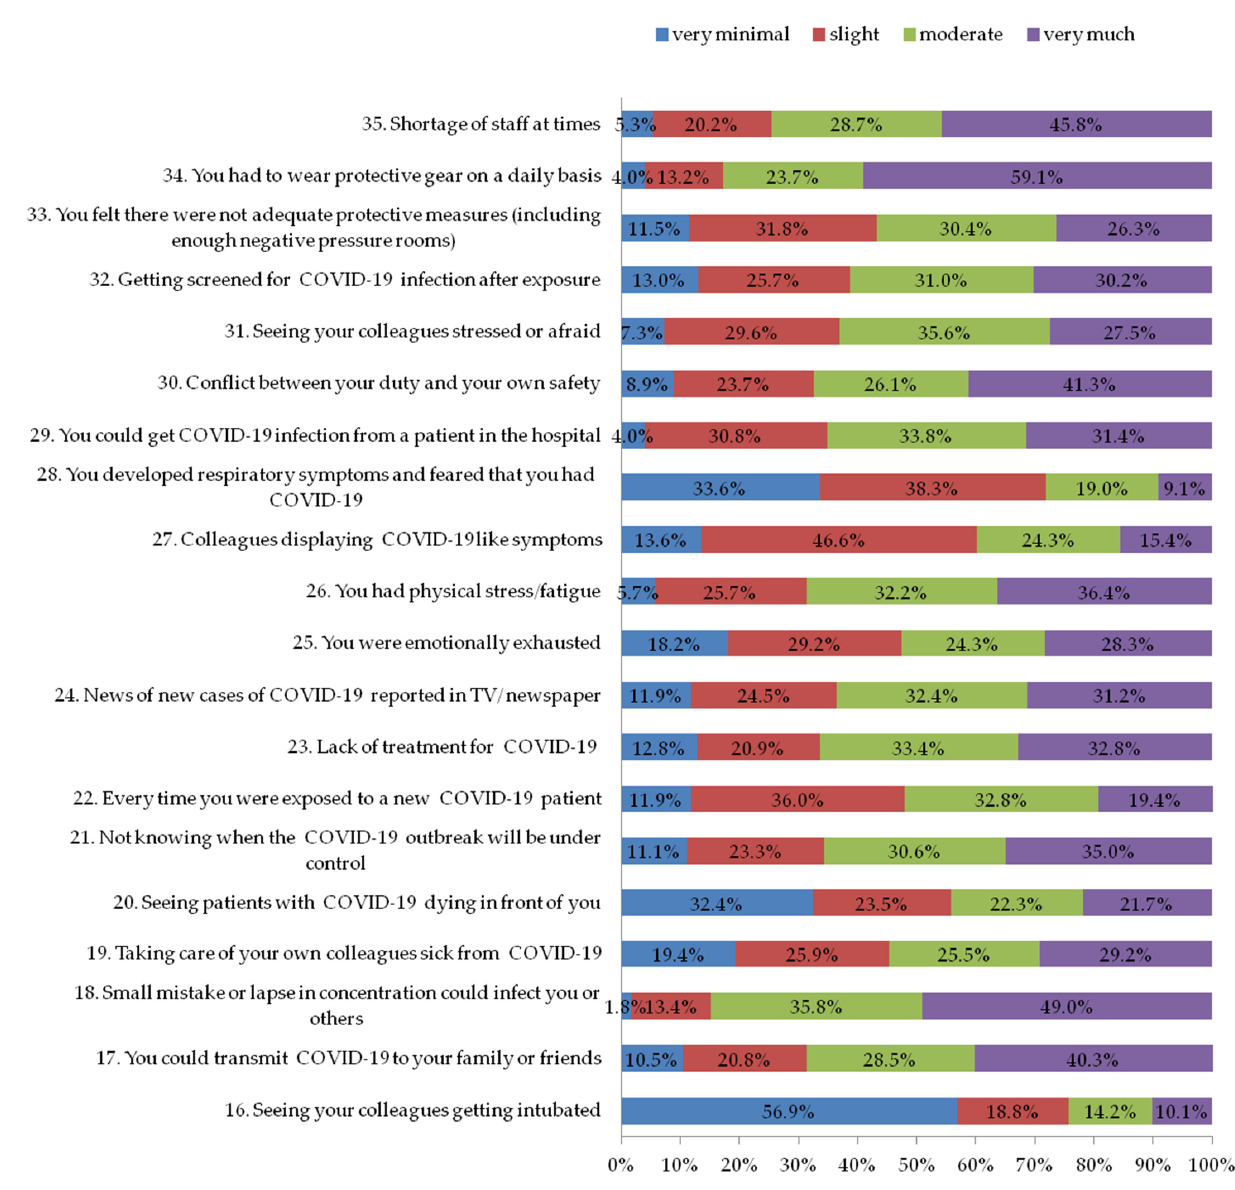
Figure 2. Factors that caused stress among staff during COVID-19 outbreak. The third section of the questionnaire explores the factors available to hospital staff, either directly or indirectly, that could have helped to reduce their stress and it consisted of 14 questions (questions 36 to 49, Figure 3). Each question had a 4-point scale (0 = not at all effective; 1 = mildly effective; 2 = moderately effective; 3 = extremely effective). The internal consistency coefficient (Cronbach’s α ) was 0.80 for the degree of